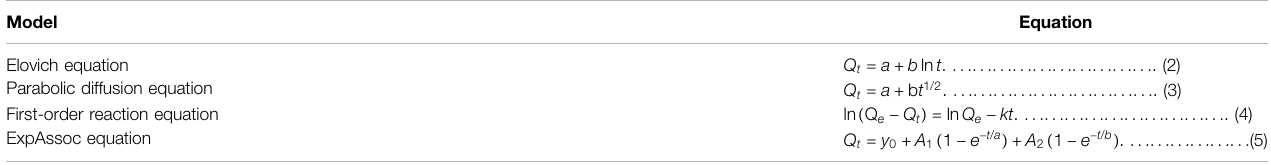
TABLE 4 | Four models of soil adsorption kinetics. Model Equation